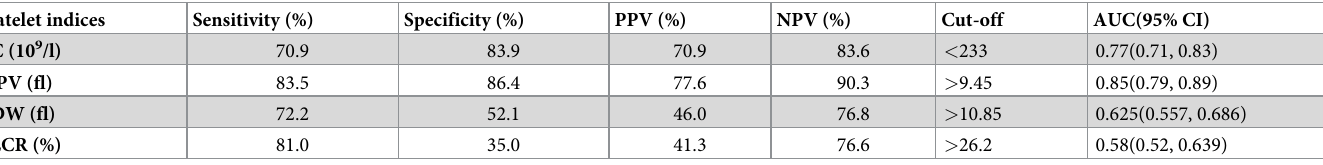
Table 4. Comparison between the diagnostic values of platelet parameters of the study participants in ACSH and MGH, Mekelle, Ethiopia, January-March2017 (n = 219). Platelet indices Sensitivity